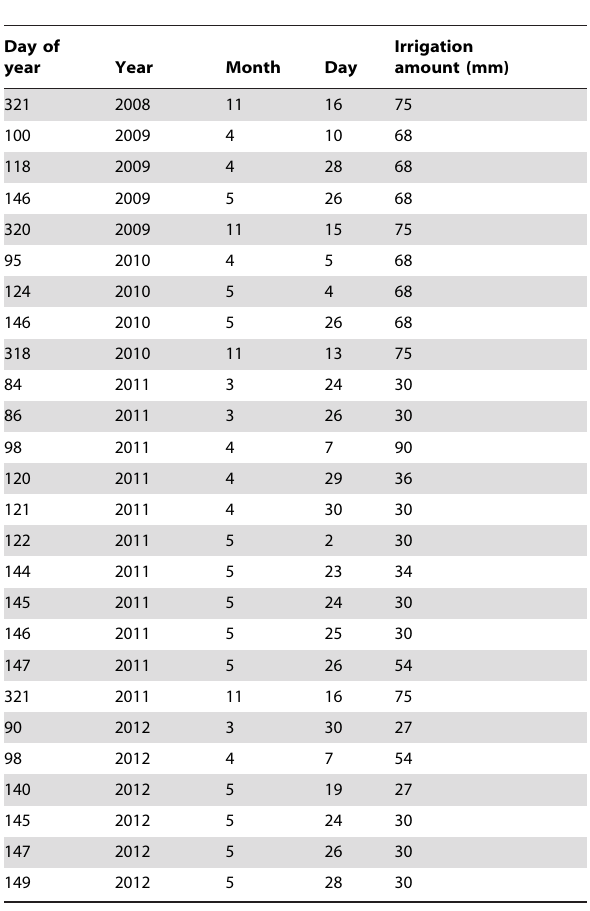
Table 2. Irrigation schedule during experimental period